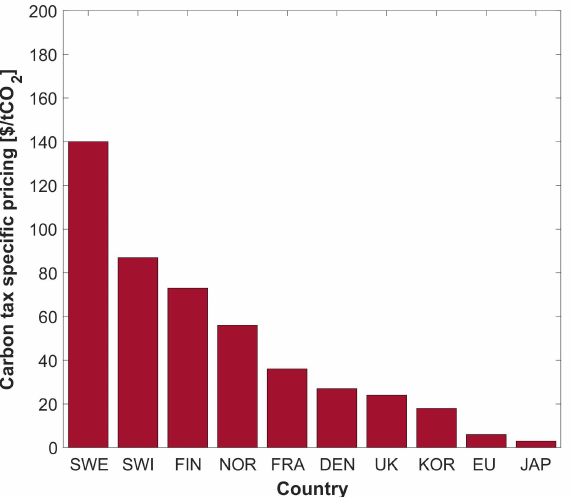
Figure 5. Values of the carbon tax provided by the 2017 edition of “State and Trend of Carbon Pricing” reports (figure elaborated using data by